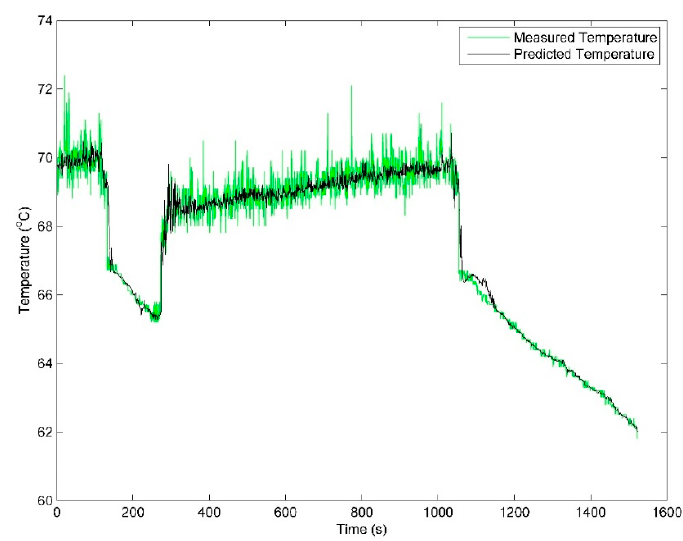
Figure 9. Actual temperature and detection temperature of an abnormal operating gearbox tank.